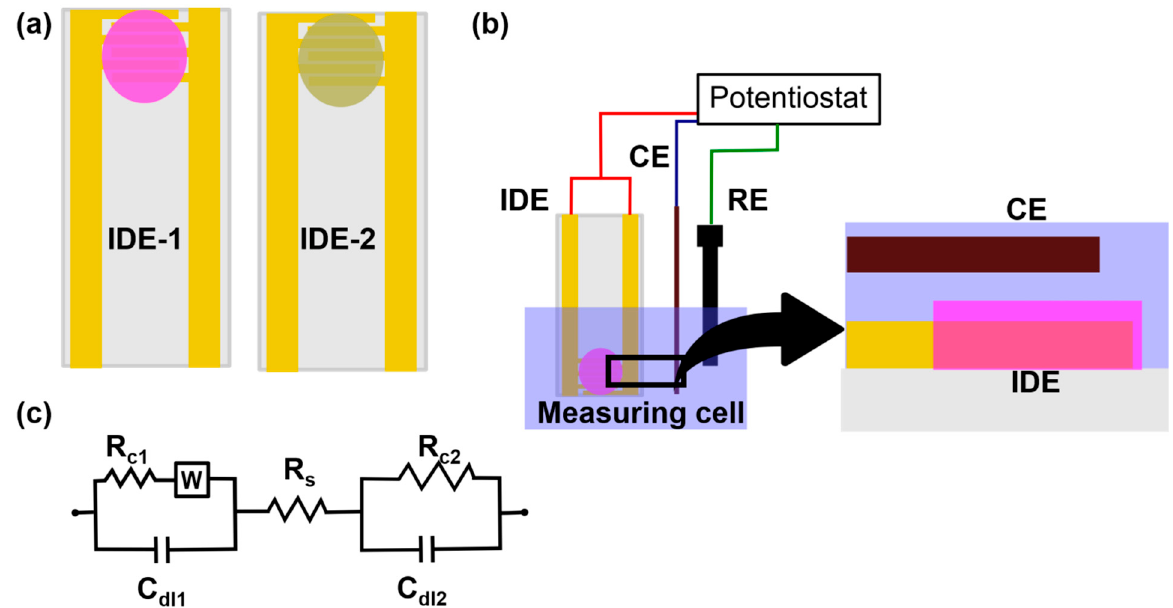
Figure 3. ( a ) A pair of interdigitated electrodes (IDE): IDE-1 represents the active membrane coated electrode and IDE-2 is the electrode coated with membrane without any active material ( b ) A schematic representing the experimental setup of a conductometric sensor with IDE, a counter electrode and a reference electrode. The zoomed in picture shows a transverse section of IDE and counter electrode ( c ) An equivalent circuit for the conductometric sensor with R C1 , W and C dl1 representing the charge transfer resistance, Warburg impedance and double layer capacitance, respectively for the IDE; R S is the solution resistance; and R C2 and C dl2 representing the charge transfer resistance and double layer capacitance for the counter electrode respectively.